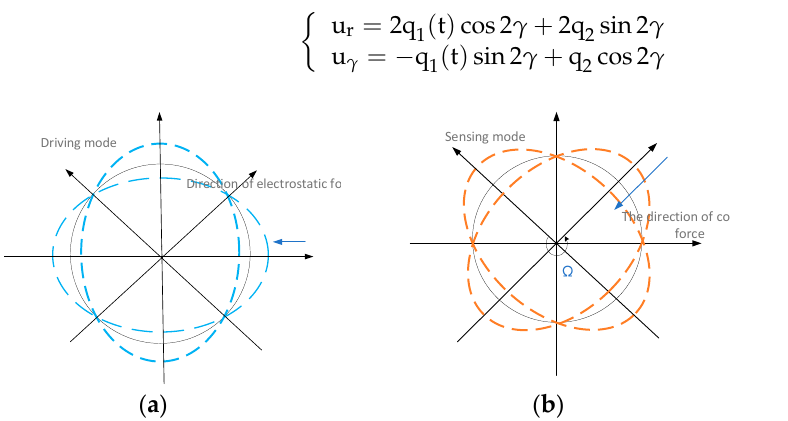
Figure 3. The operating modes of the resonant ring: ( a ) driving mode of the ring resonator; ( b ) sensing mode of the ring resonator.